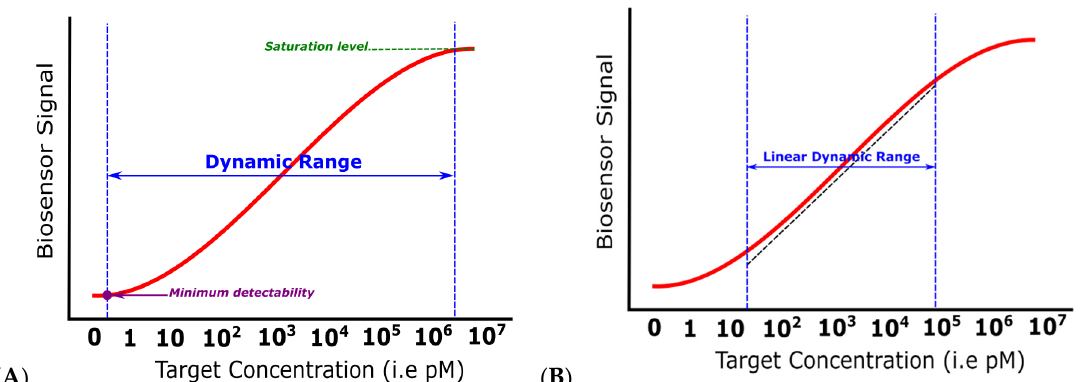
Figure 7. ( A ) The illustrated dynamic range in a biosensor standard curve with the dose–response fitting curve. ( B ) Linear dynamic range.